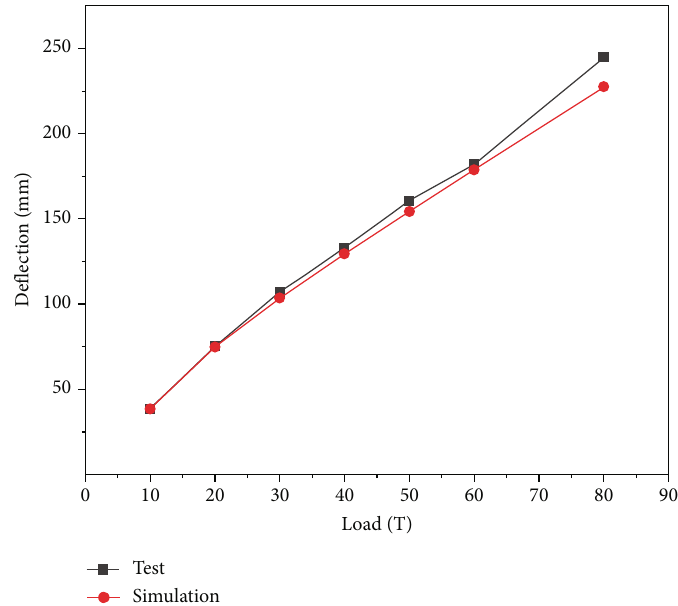
Figure 7: Comparison of simulated and experimental tire radial sti ff ness curves.